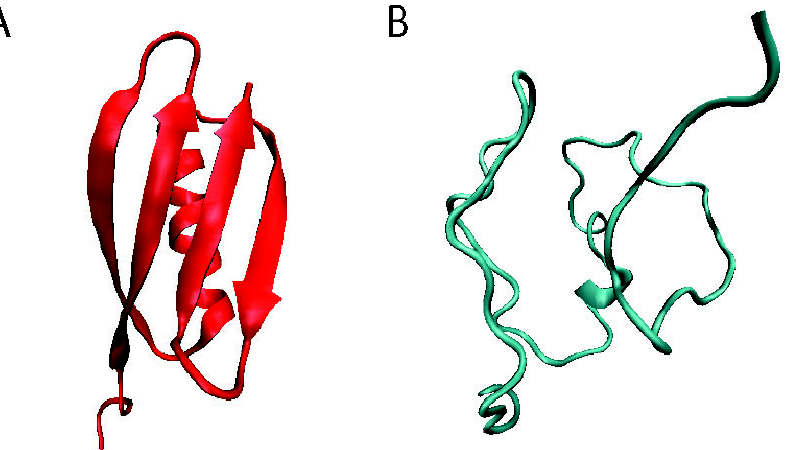
Figure 4. (A) The native structure of protein G and (B) the 5.7 A˚ starting structure used for comparing the ST and Standard Rosetta variants.